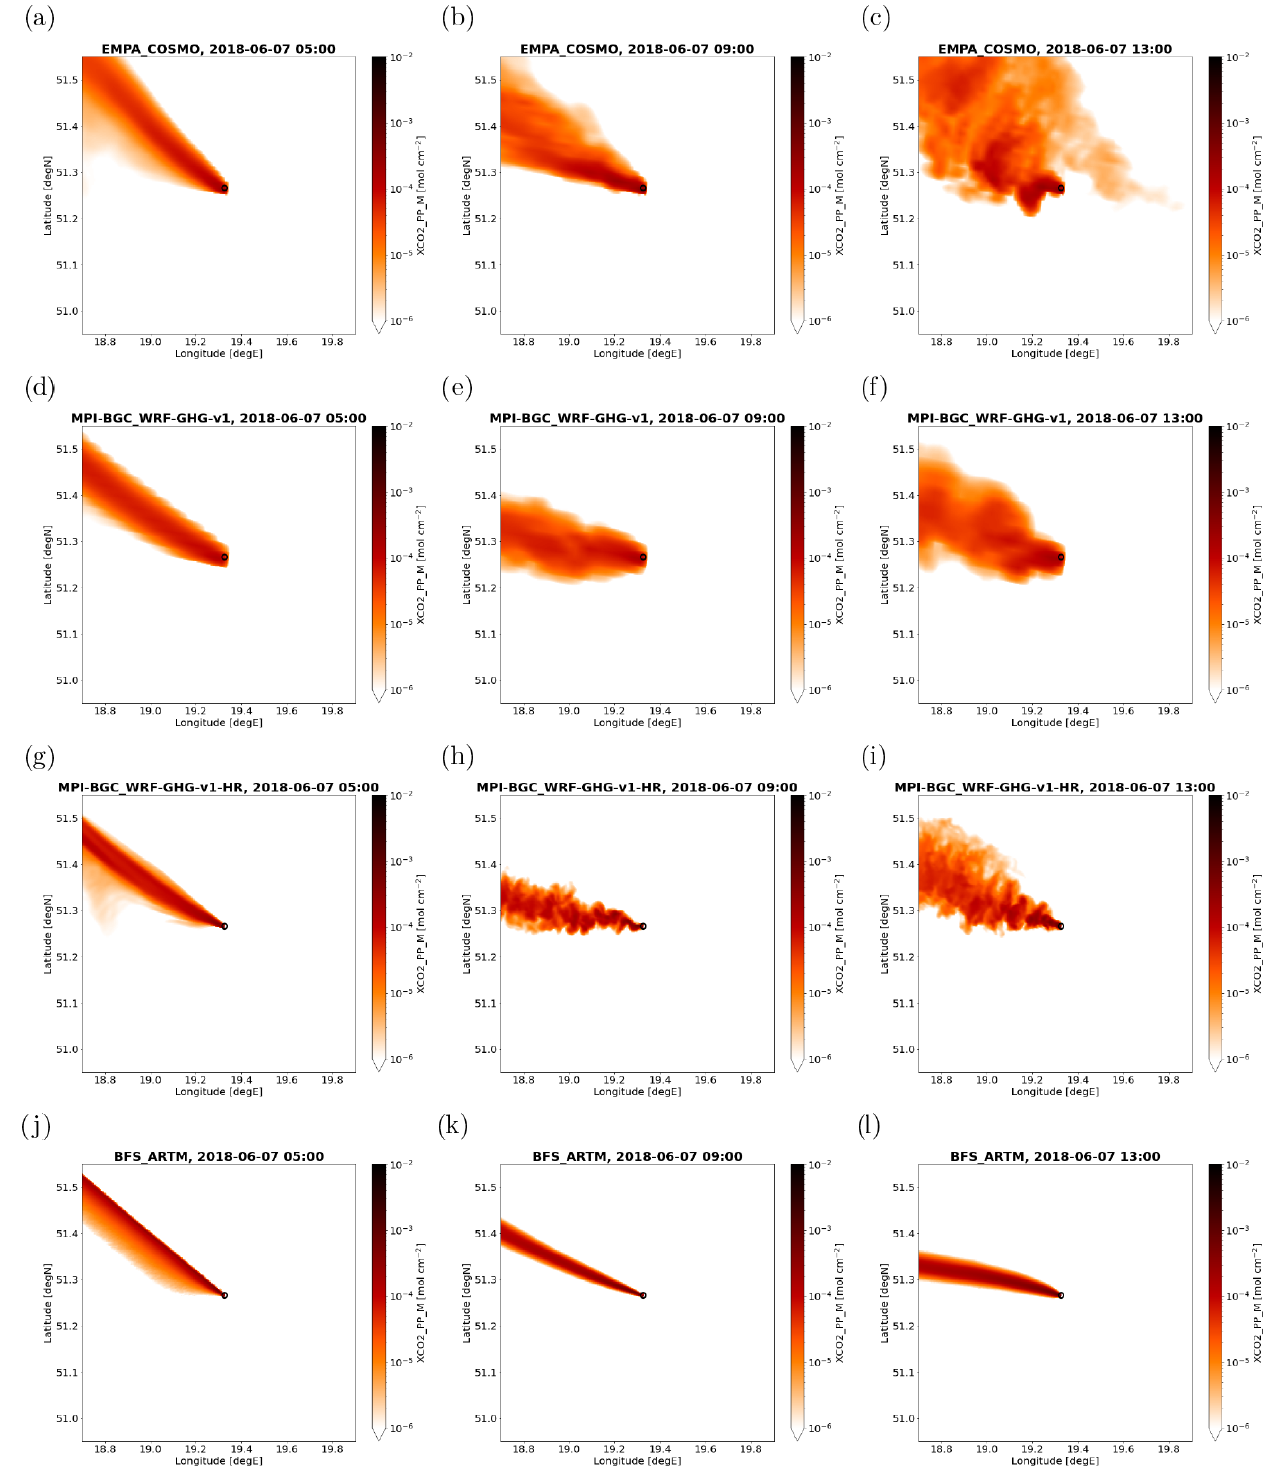
Figure 2. Time evolution of the Bełchatów total column XCO 2 plume on 7 June 2018 from 05:00 to 13:00UTC in the NWP models of COSMO (a–c) and WRF-GHG (d–i) and in the Lagrangian model ARTM (j–l) .